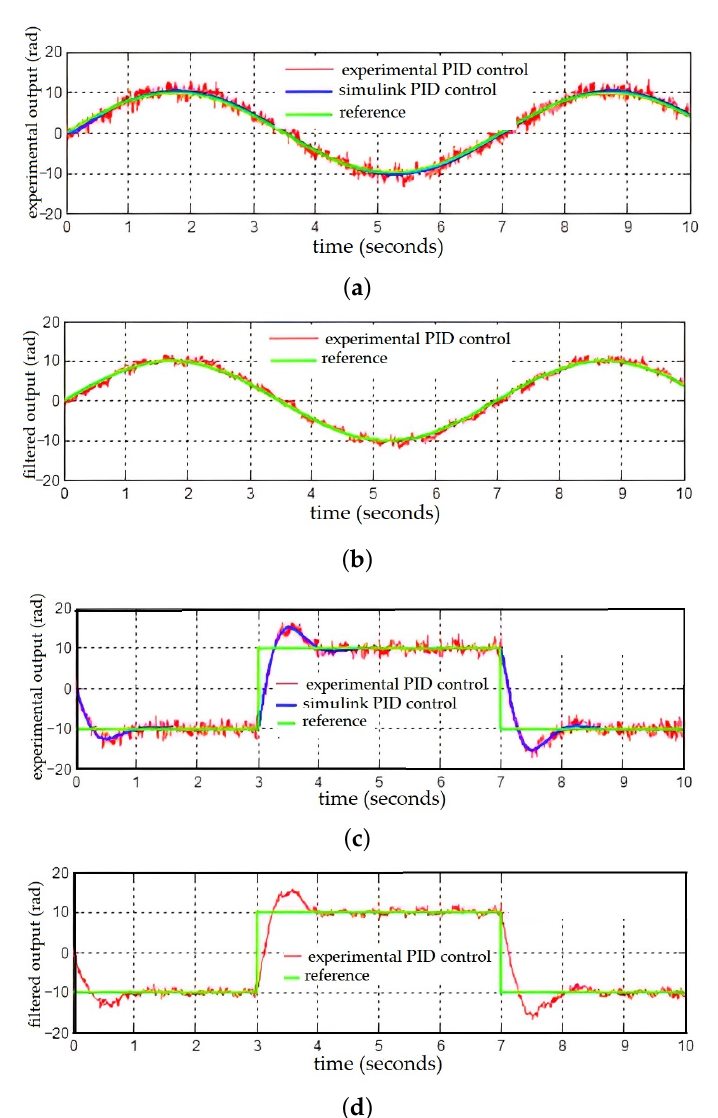
Figure 14. The experimental PID controller for angular position tracking—sine input tracking—( a , b ) and the experimental PID controller for angular position tracking—square input tracking ( c , d